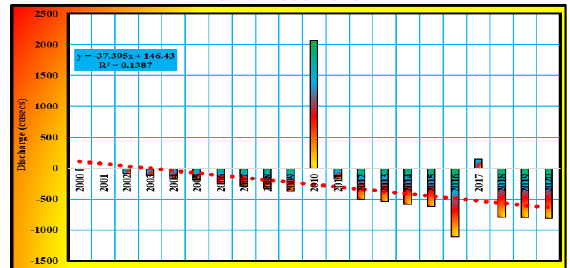
Figure 21: Represents July Month Discharge Trend Line of Ghotki Feeder Canal 2000-2020